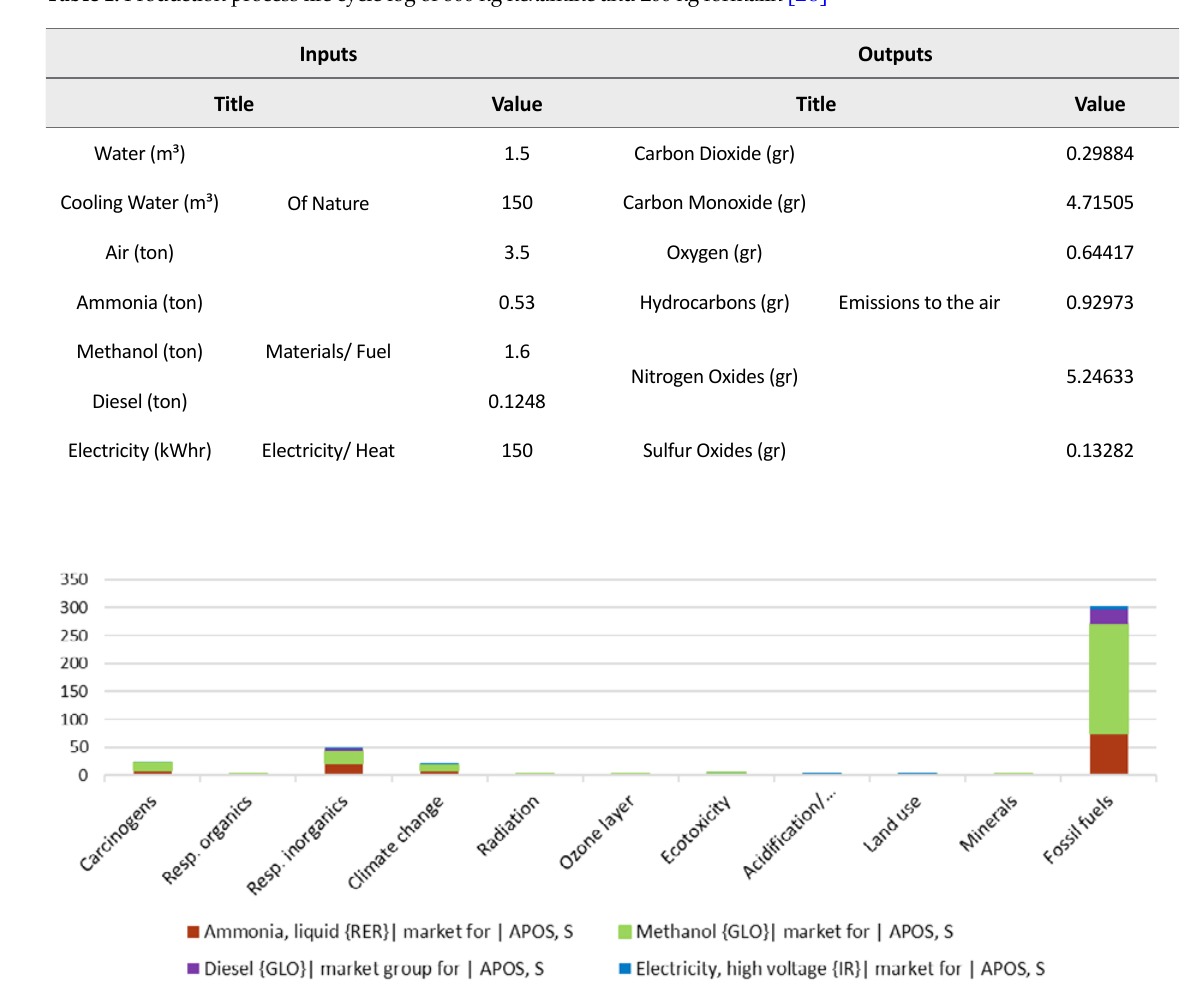
Taghizadeh Isini L, et al. Life Cycle Assessment of Formalin and Hexamine Production Units. J Adv Environ Health Res. 2022;